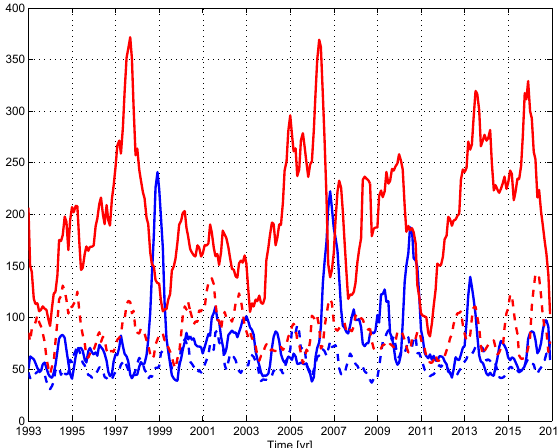
Figure 7. Time series of the monthly mean EKE (mmEKE) from 1993 to 2016. Red lines refer to the mmEKE of anticyclonic (solid) and cyclonic (dashed) eddies in the southern part of the basin (37–39 ◦ N), while blue lines refer to the mmEKE of anticyclonic (solid) and cyclonic (dashed) eddies in the northern part of the basin (39–42 ◦